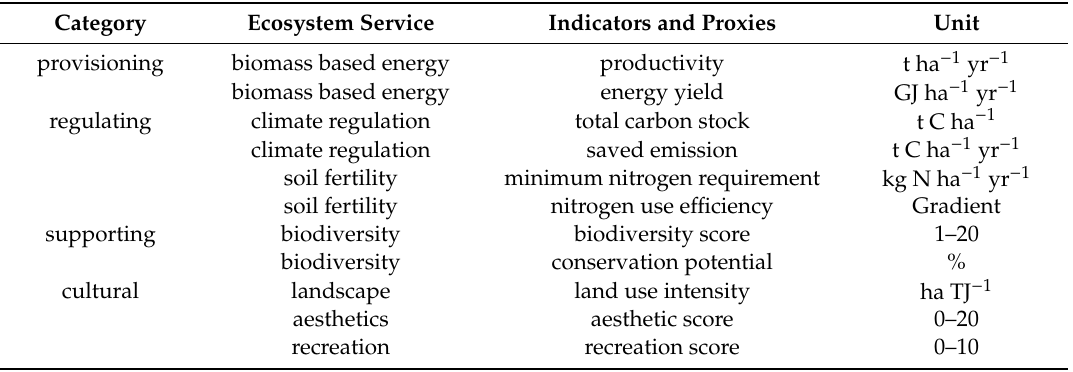
Table 1. Selection of ecosystem services included in the analysis, with their assigned indicators or proxy along with their unit of measurement.